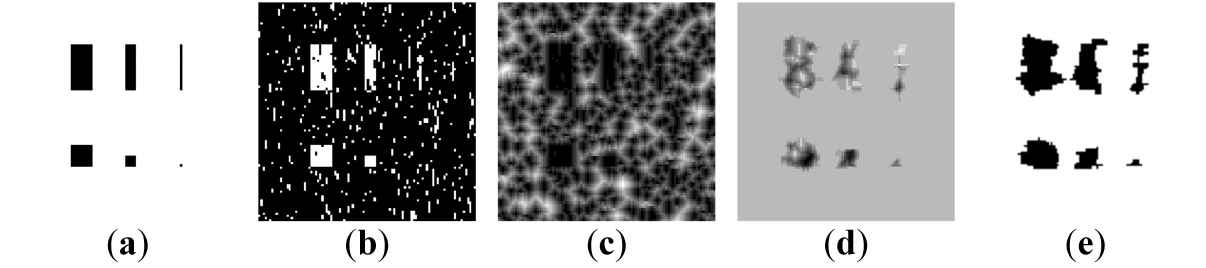
Figure 7. Big clusters of initially excited cells result in interpretable self-organized patterns ( ν = 0 . 5 , n = τ = 20 , δ = 0 . 01 ). ( a ) The secret image ( b ) Initially excited cells (shown in white) ( c ) The self-organized pattern ( d ) The difference image ( e ) The binarised initially excited